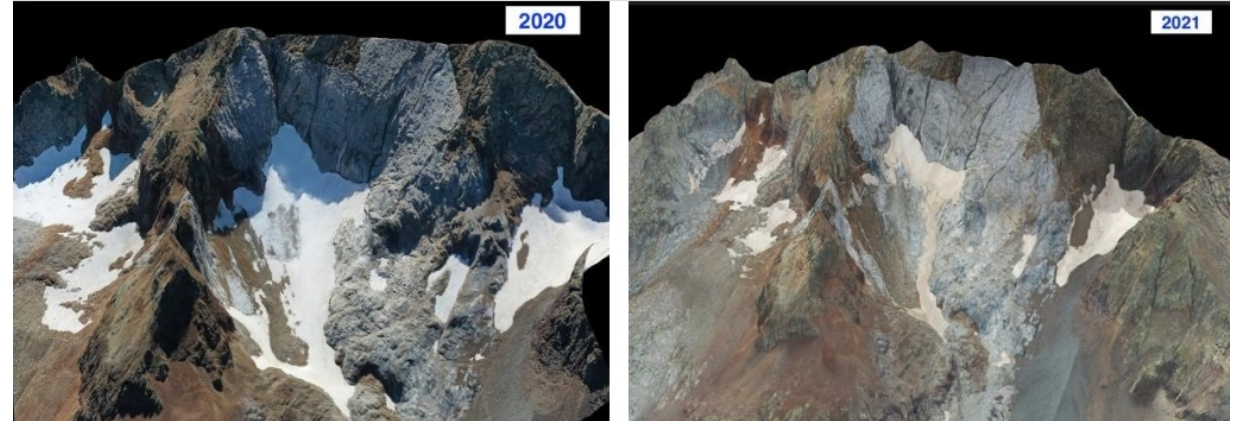
Figure 5. Drone photography of the Infierno Glacier, 31 August 2020 ( left ) and 5 September 2021 ( right ). Snow-firn cover is very different between two successive years. Photos by C. Mart í n.